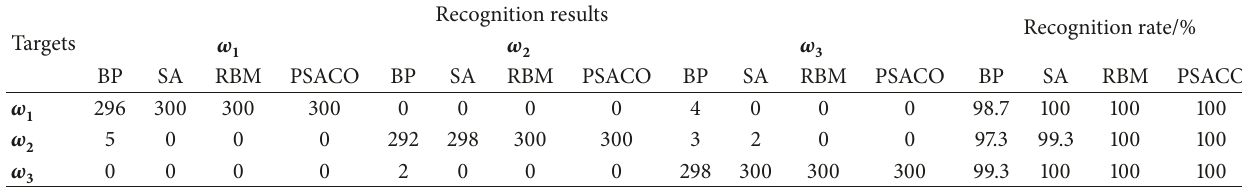
Table 5: Recognition results of CNIS-II for original sample.